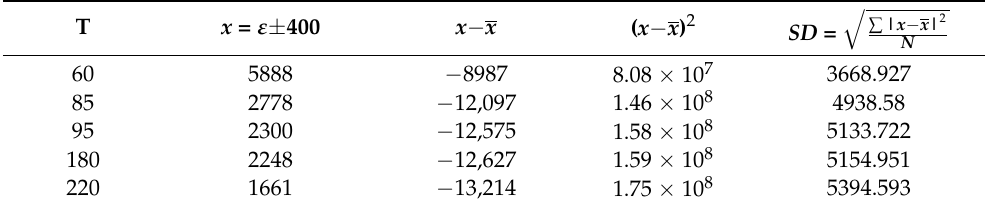
Table 2. The standard deviation values for microstrain with different film thickness.